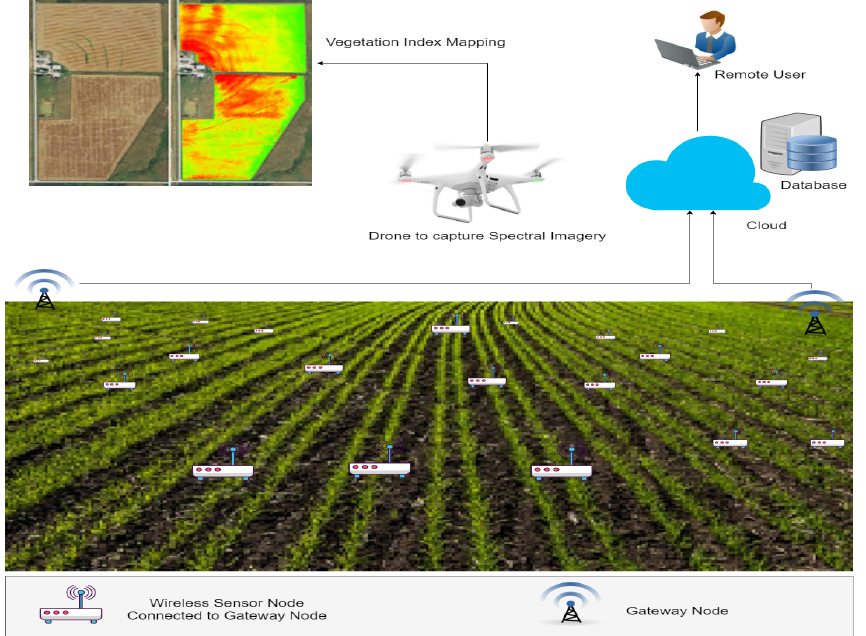
Figure 1. System